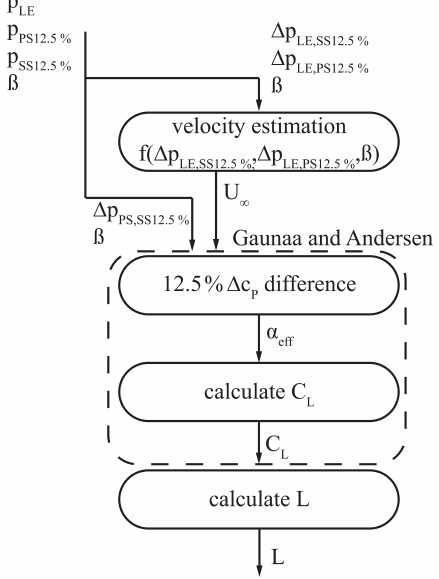
Figure 9. Flow chart for estimation of the unsteady lift based on selected surface pressure